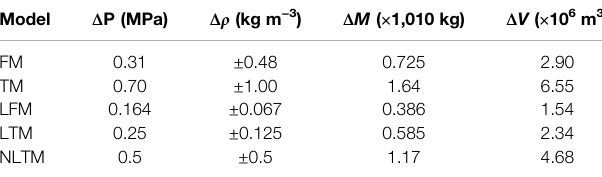
TABLE5| Sourcepressure Δ Panddensitychanges Δ ρ andassociatedmassand volume changes ( Δ M and Δ V , respectively) for minimum resolvable surface residual gravity changes and uplift obtained from the 3D models.